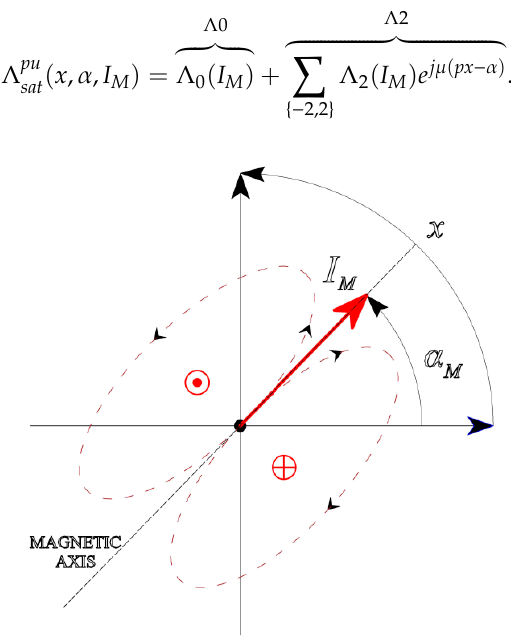
Figure 5. Magnetizing current vector diagram, where x is the angular position with reference to the stator, I M is the magnetizing current vector, and α M is the phase of the magnetizing current vector. The constant component of series (8), Λ 0, can be interpreted as a function that models permeance decrease uniformly around the entire circumference of the machine due to magnetic core saturation.